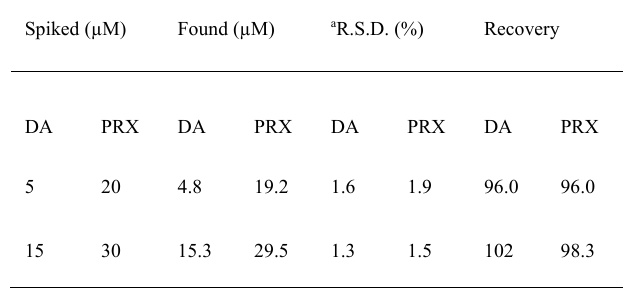
Table 2. Estimationof DA and PRX in diluted (20-fold)